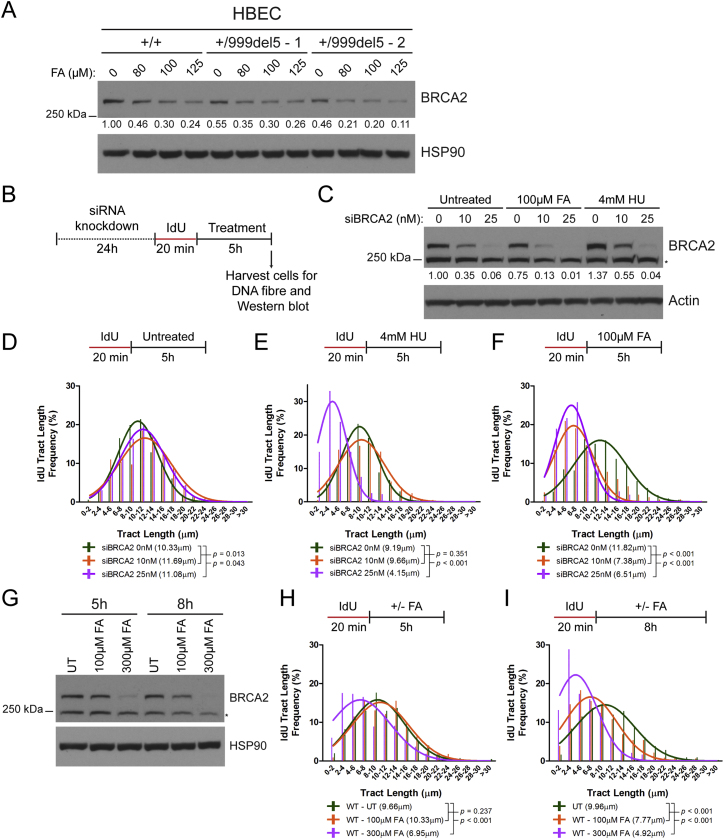
Related to Figure 5(A) BRCA2 protein levels in BRCA2+/+ and BRCA2+/999del5 human breast epithelial cells (HBECs) treated with increasing doses of FA for 5h. Numbers below the BRCA2 blot represent densitometric measurements of BRCA2 protein levels normalized to loading control and untreated BRCA2+/+ cells (lane 1). Although BRCA2+/999del5 −1 HBECs have lower pre-existing levels of BRCA2 protein than their BRCA2+/+ counterparts, similar levels are reached after formaldehyde exposure. However, since BRCA2+/999del5 −1 HBECs exhibit replication tract instability after formaldehyde exposure whereas their BRCA2+/+ counterparts do not (Figure 2), these observations may reflect differences between these non-isogenic human cell lines in the kinetics of aldehyde-induced BRCA2 depletion, and/or in the level of BRCA2 that is adequate for function.(B) Experimental set-up for the siRNA knockdown DNA fiber experiment.(C) BRCA2 protein levels of wild-type HeLa Kyoto cells following transfection with BRCA2 short interfering RNA (siBRCA2) in combination with the indicated treatments. Numbers below the BRCA2 blot show the densitometric measurements of BRCA2 band intensities normalized to loading control and relative to the untreated control (lane 1).(D–F) IdU tract length frequency distributions of wild-type HeLa Kyoto cells treated under the indicated conditions.(G) BRCA2 protein levels in wild-type HeLa Kyoto cells after treatment with 100μM and 300μM FA for 5h and 8h.(H–I) IdU tract length frequency distributions in wild-type HeLa Kyoto cells after treatment with 100μM and 300μM FA for 5h and 8h respectively.